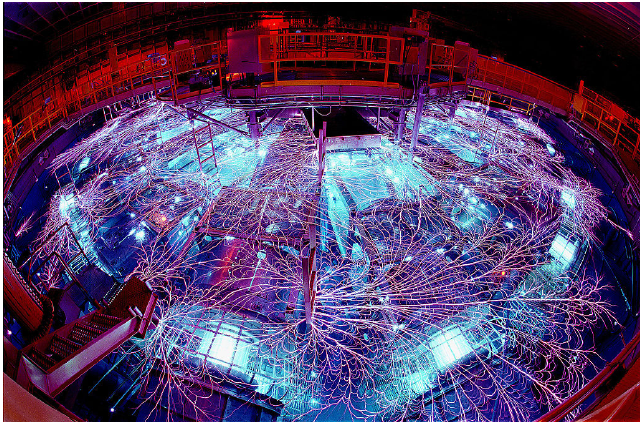
Figure 4. The Z machine at SNL. c (cid:13) Sandia National Laboratories.